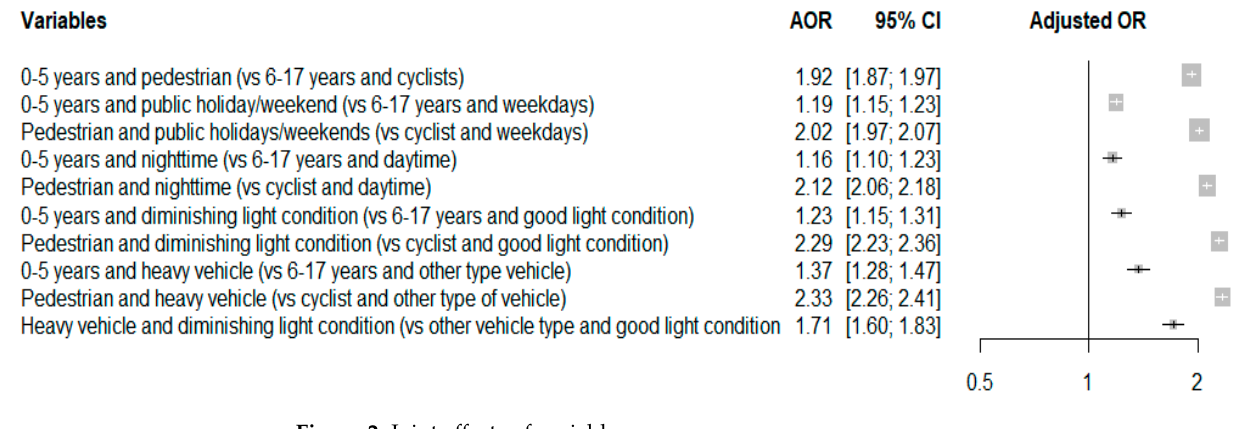
Figure 2. Joint effects of variables.